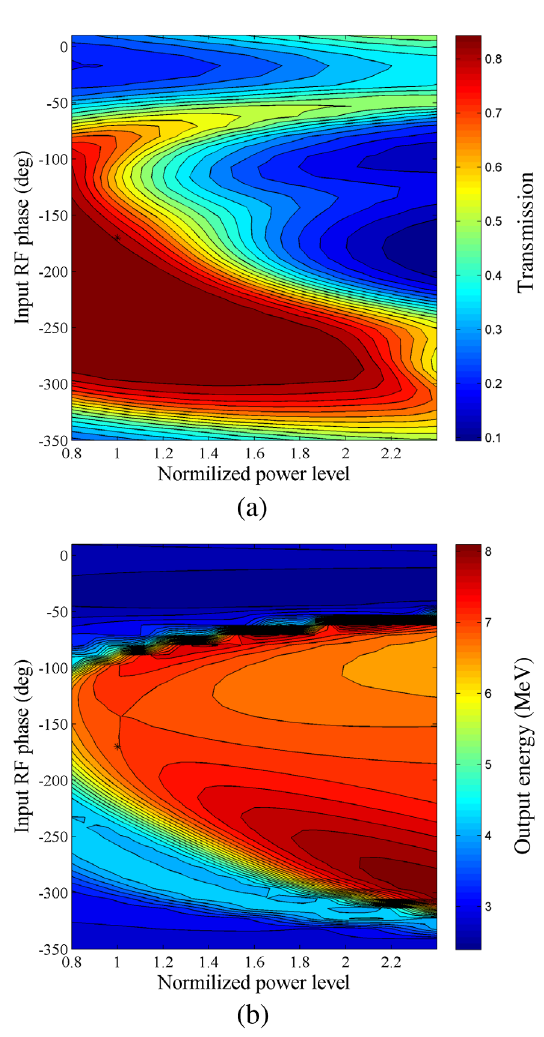
FIG. 13. (a) Transmission from the entrance of the BMS to the exit of the IH-DTL. (b) Variation of output energy with rf power and rf phase. The black point in each plot indicates the operating point of the